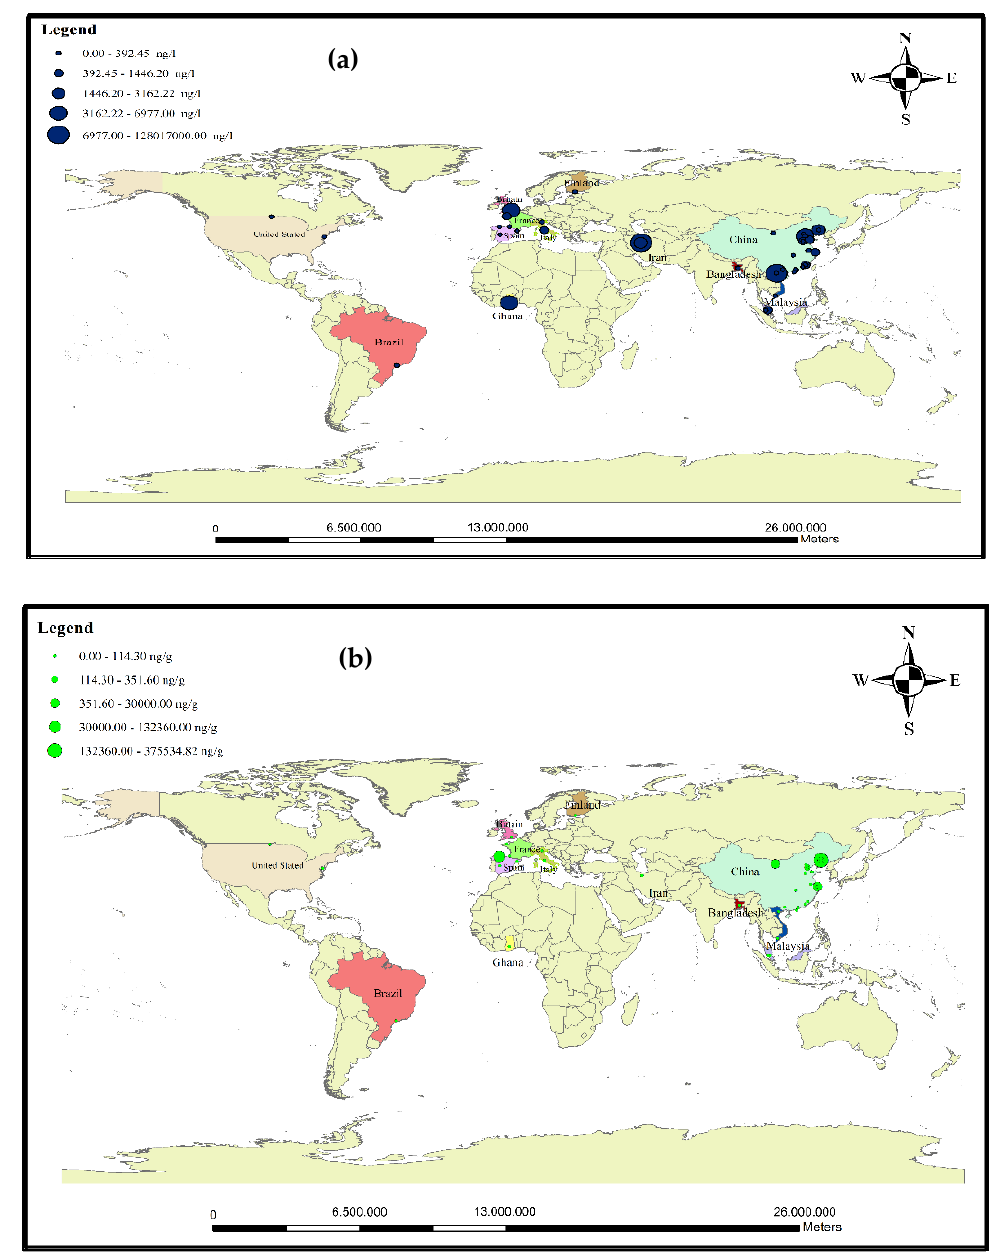
Figure 4. Map of study areas in ( a ) water and ( b ) sediments of rivers around the world.